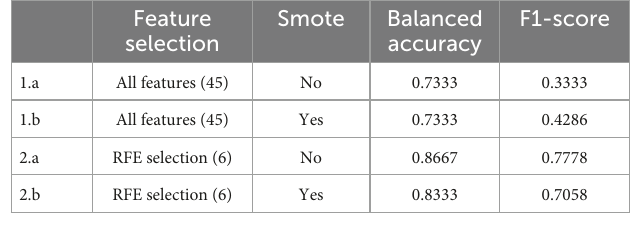
TABLE 3 Machine learning approach results.